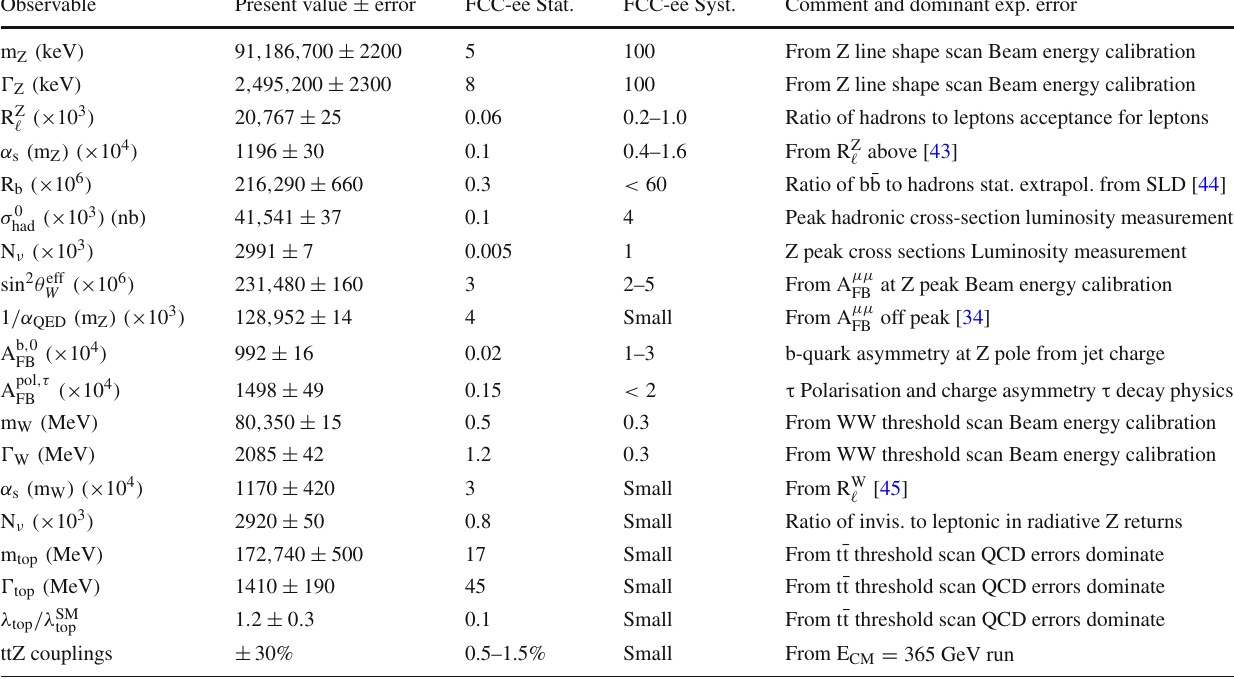
From t ¯ t threshold scan QCD errors dominate From E CM = 365 GeV